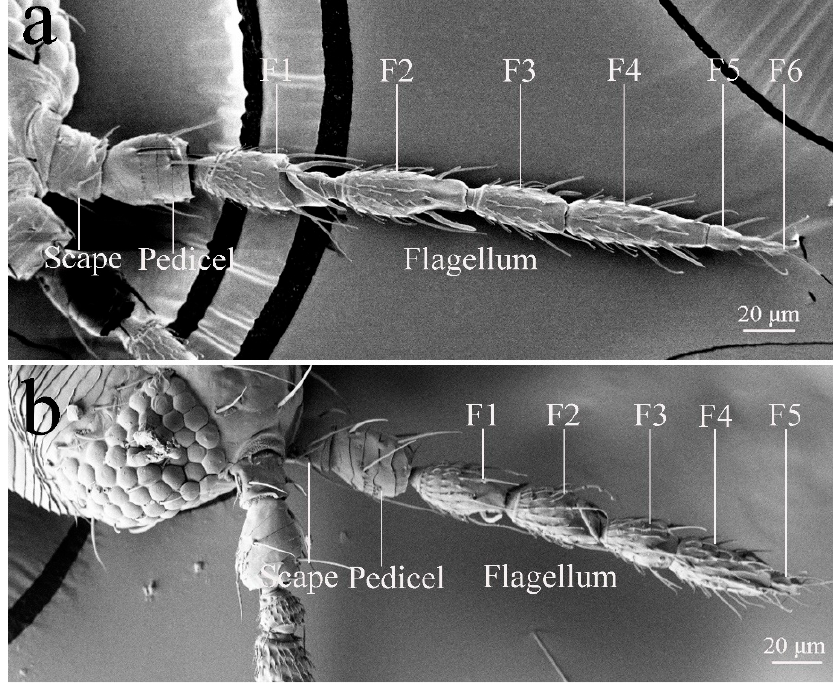
Table 1. Mean length ( μ m) of antennal segments in Megalurothrips usitatus and Thrips palmi .